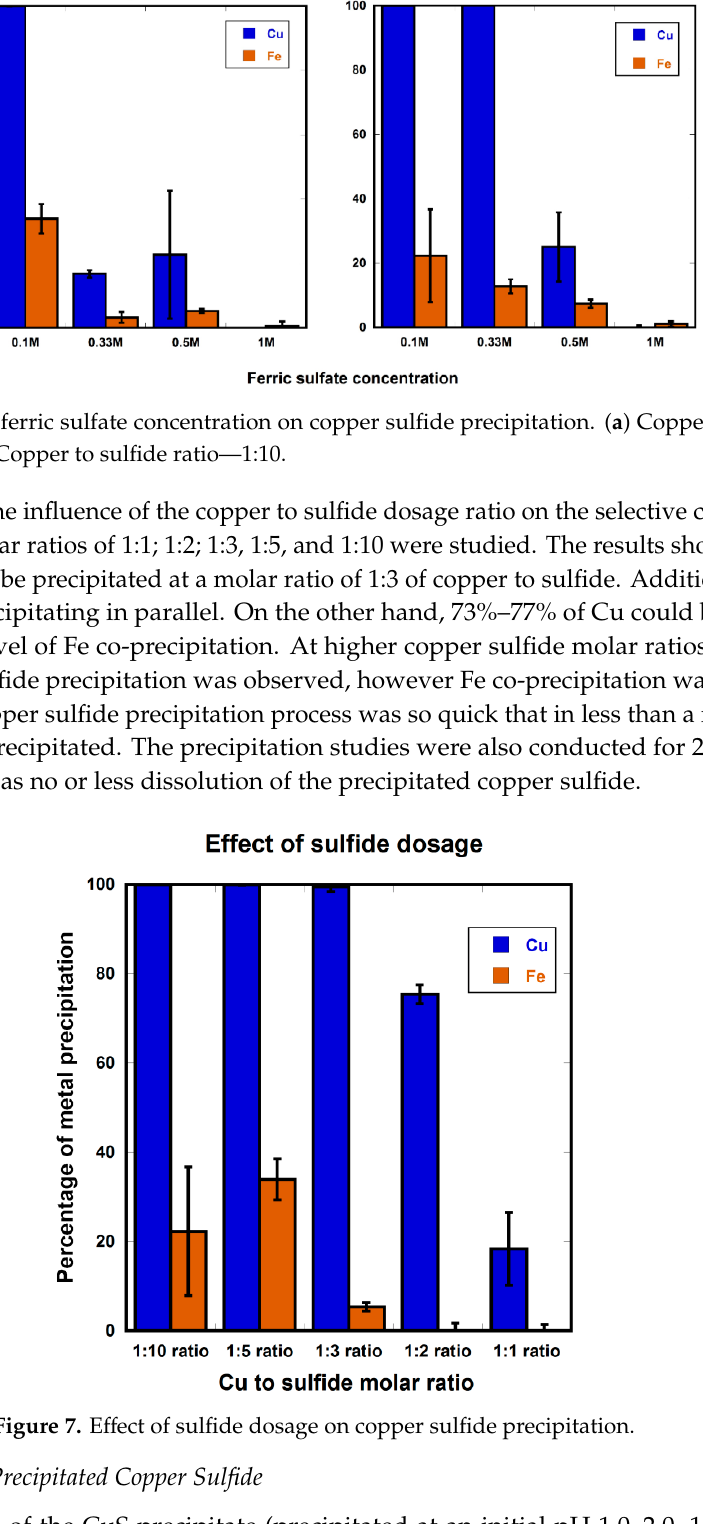
Figure 7. Effect of sulfide dosage on copper sulfide precipitation.